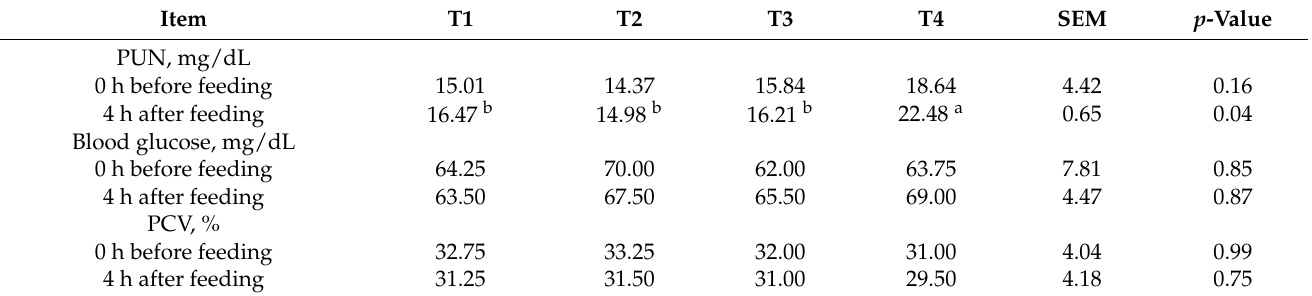
Table 3. Plasma urea nitrogen, blood glucose, and packed cell volume of Thai native sheep fed fermented sugarcane bagasse with or without additives as roughage sources.